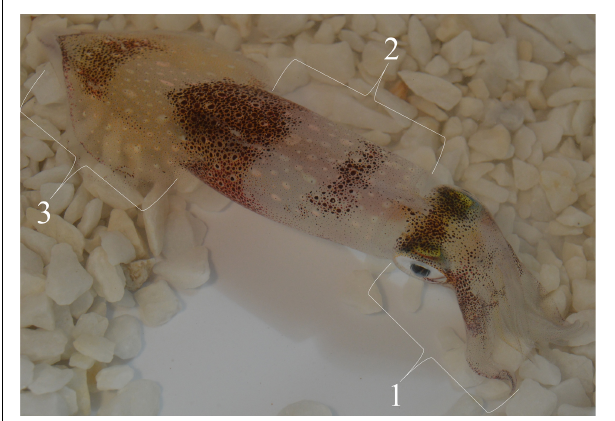
FIGURE 1 | D. pealeii (mantle length approximately 14 cm) expressing disruptive body patterning with some chromatophores expanded (dark bands), while others are retracted. Numbers indicate the different body regions measured in the study: 1 = head/arms, 2 = mantle, and 3 =